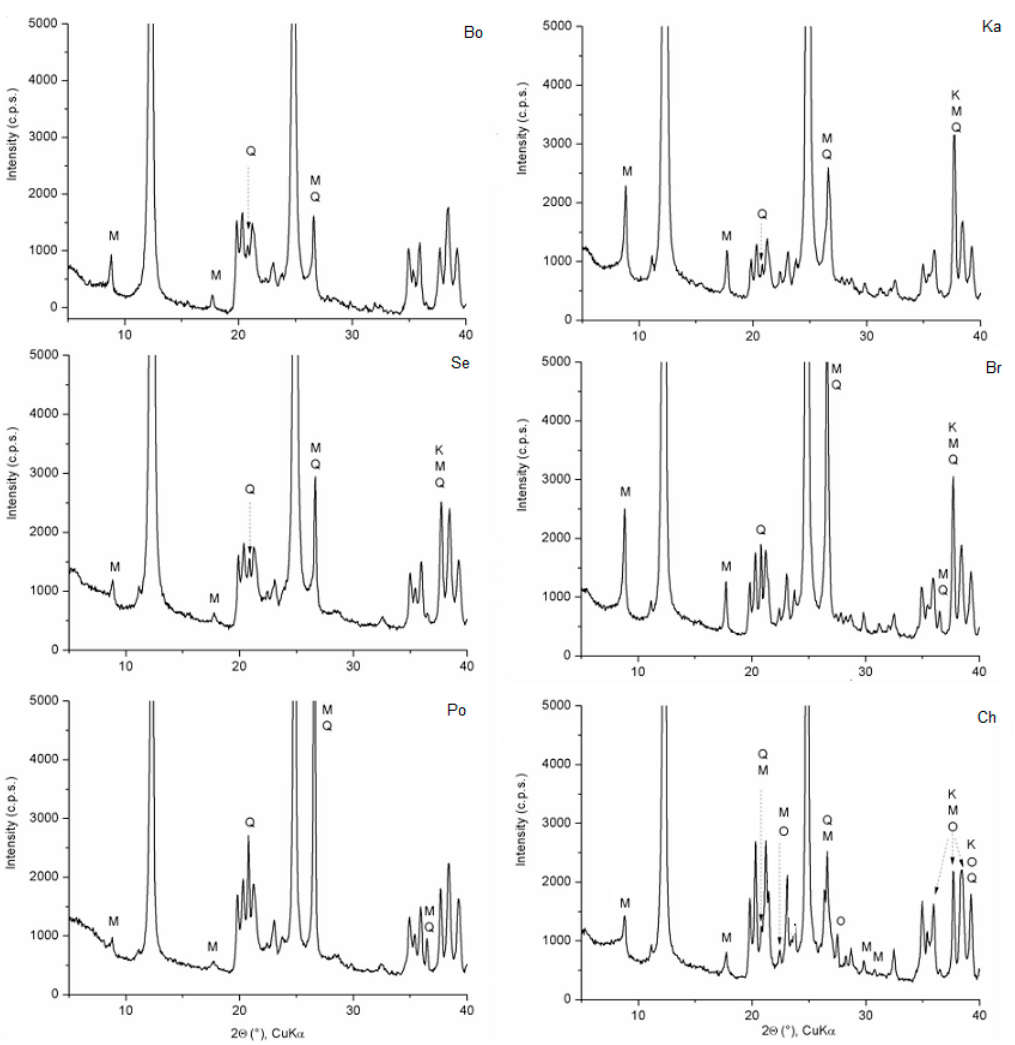
Figure 1. XRD patterns of kaolin samples from 5 to 40° 2 θ . Peaks of kaolinite (K) are unlabeled; M—muscovite, Q—quartz, and O—orthoclase.